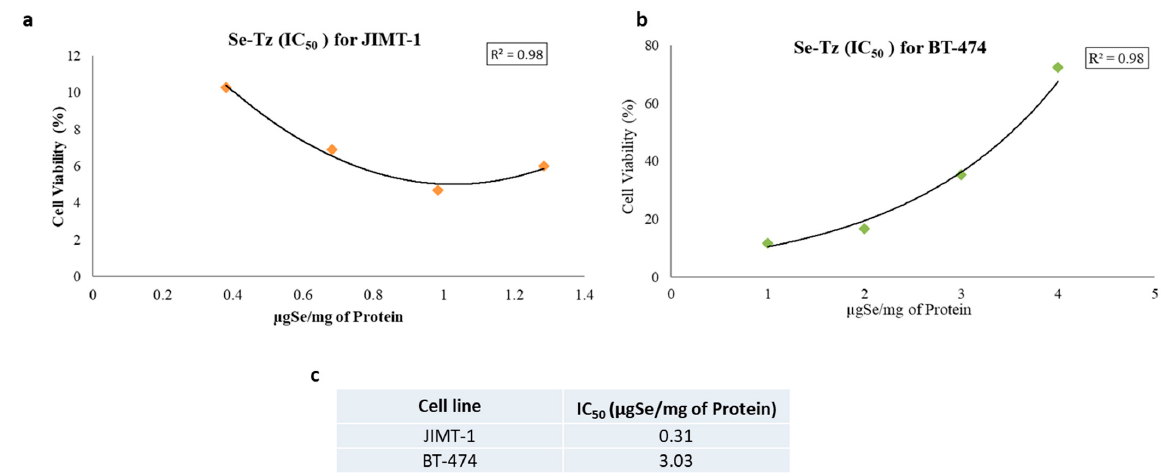
Figure 9. ( a ) IC 50 calculations for Se ‐ Trastuzumab treated JIMT ‐ 1 cells from Figure 8d and ( b ) IC 50 calculations for Se ‐ Trastuzumab treated BT ‐ 474 cells from Figure 8e. ( c ) The IC 50 is calculated here for Se ‐ Tz after treating the two cancer cell lines Trastuzumab treated BT-474 cells from Figure 8e. ( c ) The IC 50 is calculated here for Se-Tz after treating the two cancer cell from low to high concentrations using the Graph Pad Prism software from 9a and 9b. lines from low to high concentrations using the Graph Pad Prism software from 9a and